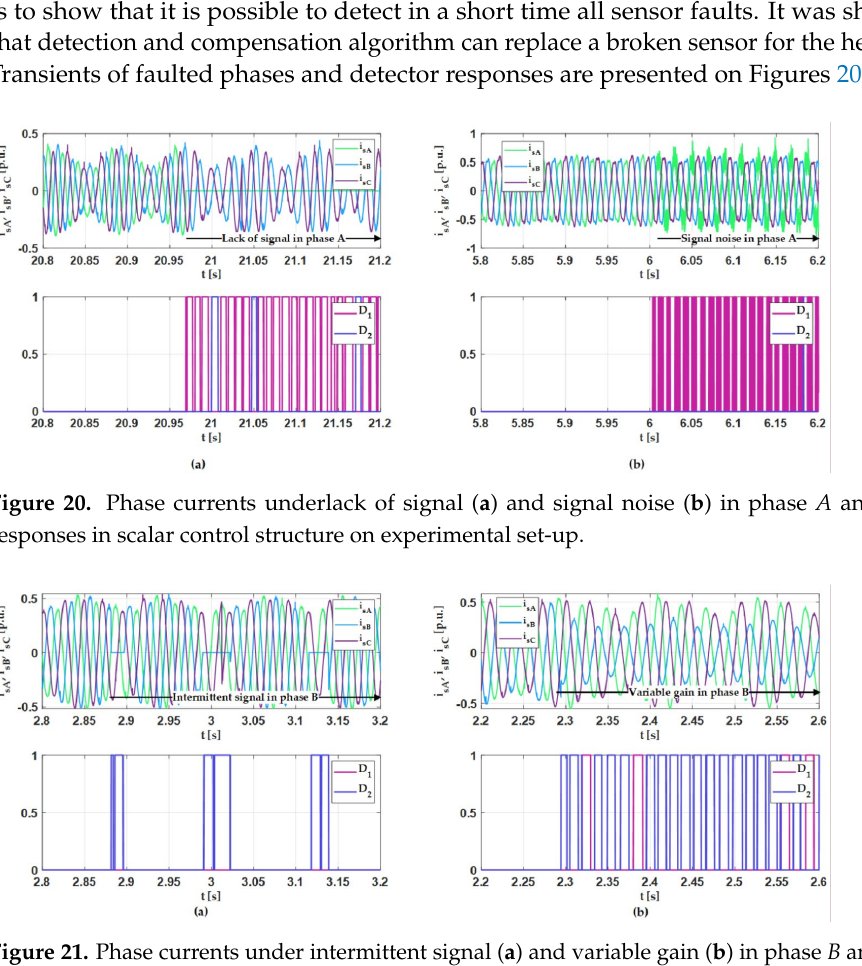
Figure 21. Phase currents under intermittent signal ( a ) and variable gain ( b ) in phase B and detector responses in scalar control structure on experimental